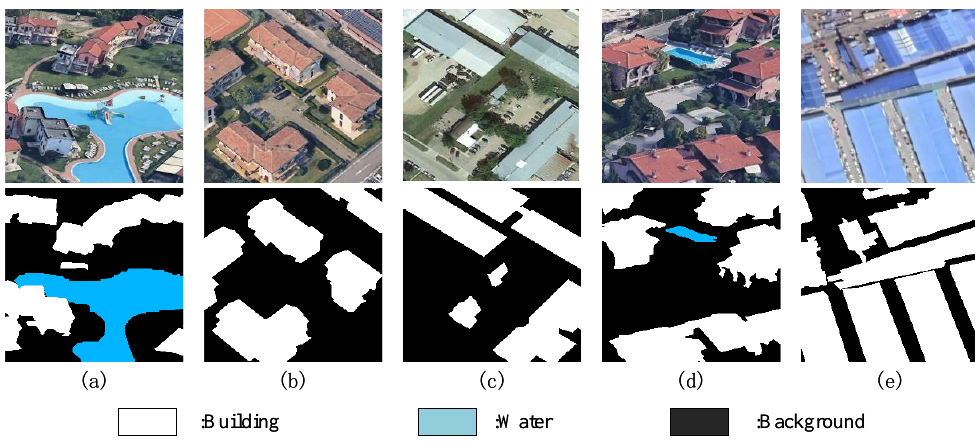
Figure 7. Homemade land cover dataset part of the picture display. ( a ) Villa area; ( b ) Urban residential area; ( c ) Rural area; ( d ) Urban residential area; ( e ) Factory